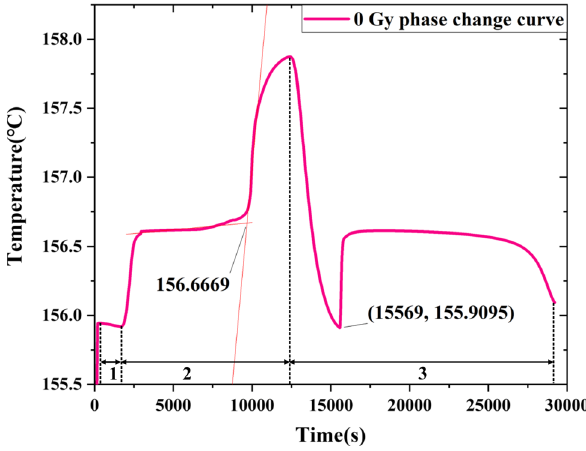
Fig. 8 Mean curves of the displaced atoms and displaced atoms in the four outgoing directions finally generated by PKA with 10 KeV kinetic energy in In